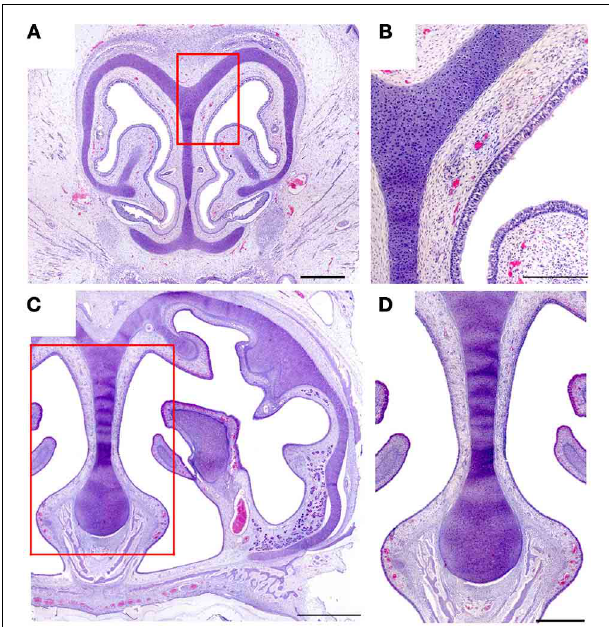
FIGURE 8 | Hematoxylin-eosin-stained transverse sections of the nasal cavity of a newborn, at the levels corresponding to the murine ganglion of Grüneberg (A) and septal organ (C). (B,D) Details of (A,C) , respectively. Scale bars: (A) 500 μ m; (B) 250 μ m; (C) 1000 μ m; (D) 500 μ